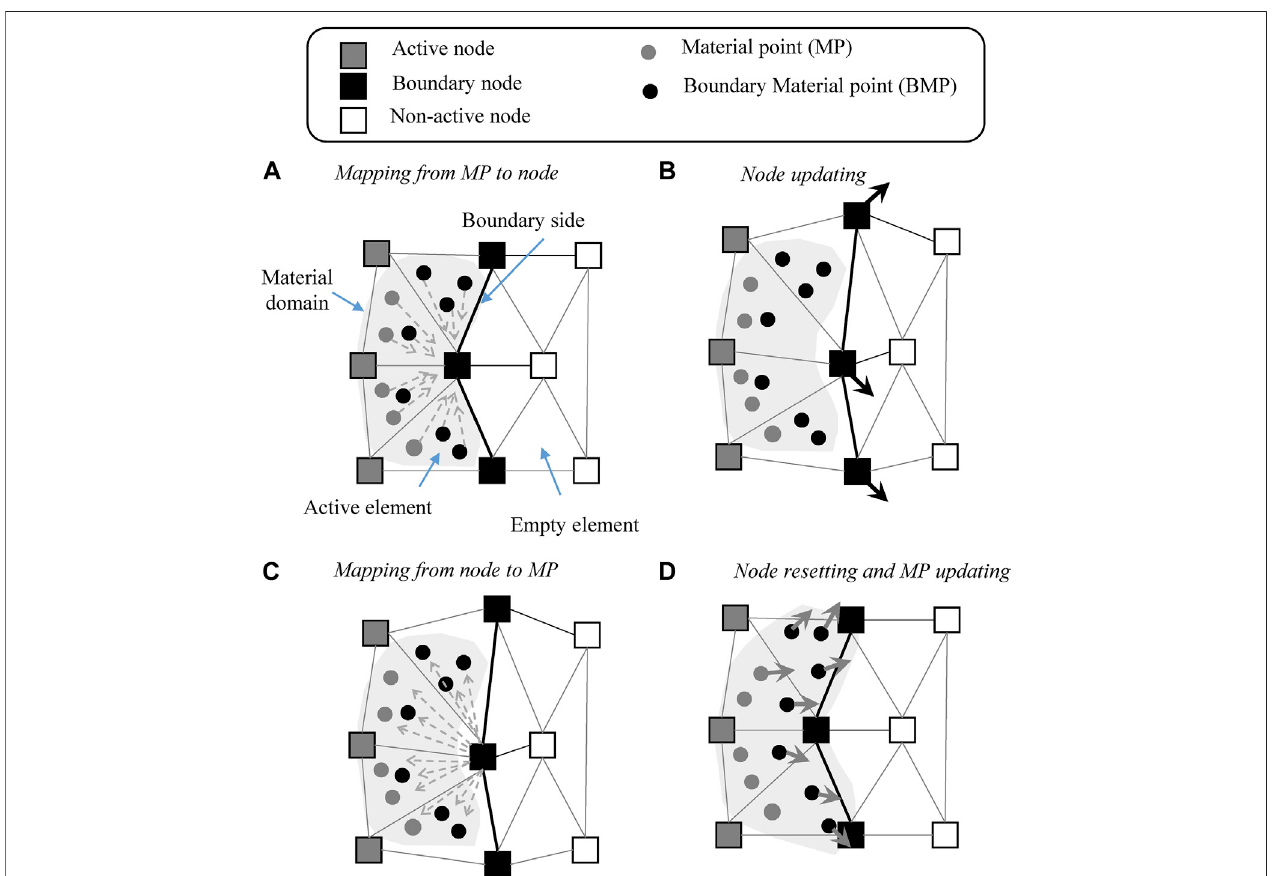
FIGURE2| Schematicofthematerialpoint method. (A) Mappingfrom MPtonode. (B) Nodeupdating. (C) Mapping fromnode toMP. (D) Node resetting and MP updating.